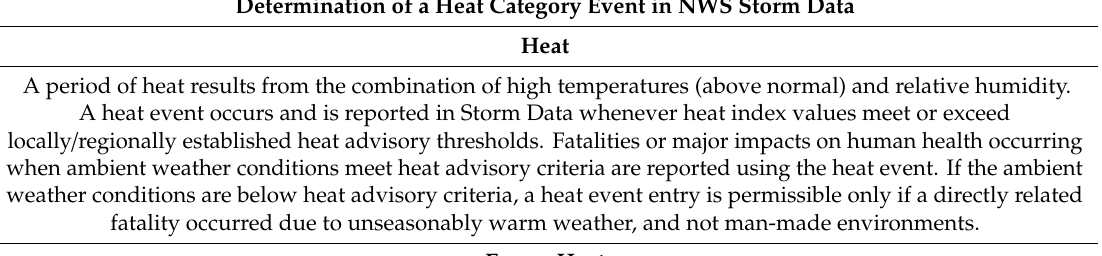
Table A1. Determination of heat and excess heat. Determination of a Heat Category Event in NWS Storm